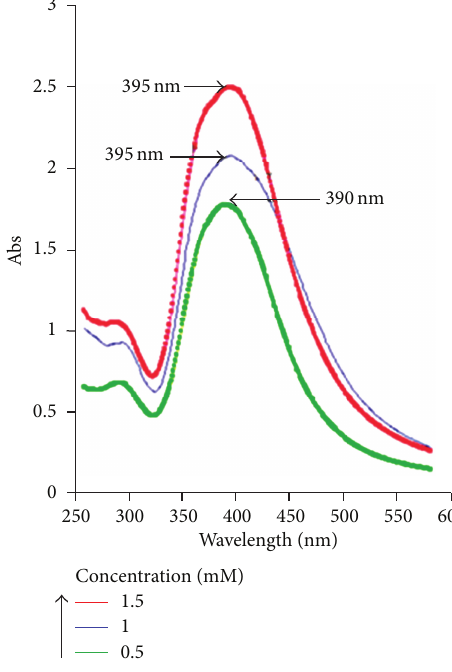
Figure 5: UV-Vis spectra of silver nanoparticles in nylon-6,6 membranes. Nanoparticles were prepared using aqueous AgNO 3 at 0.5 mM, 1.0mM, and 1.5 mM,